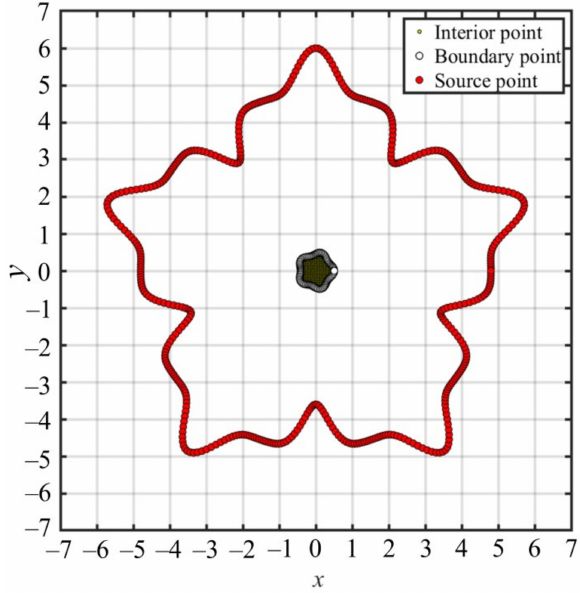
Figure 18. The fictitious